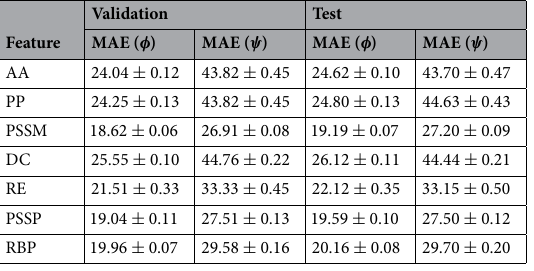
Table 1. The MAE of each single feature in predicting the torsion angles using ESIDEN on the D2020 dataset.